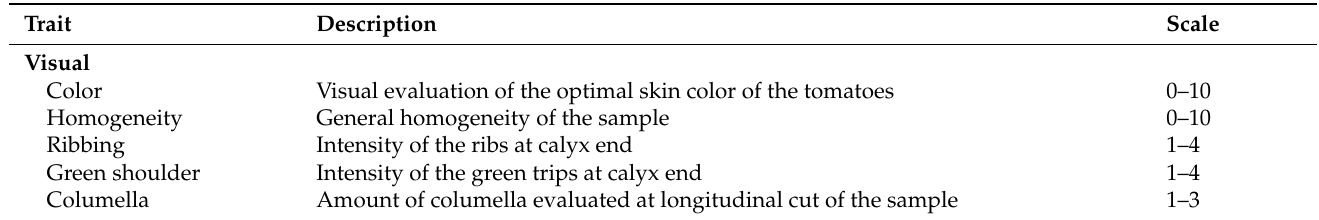
Table 1. Description and score scale for all the evaluated